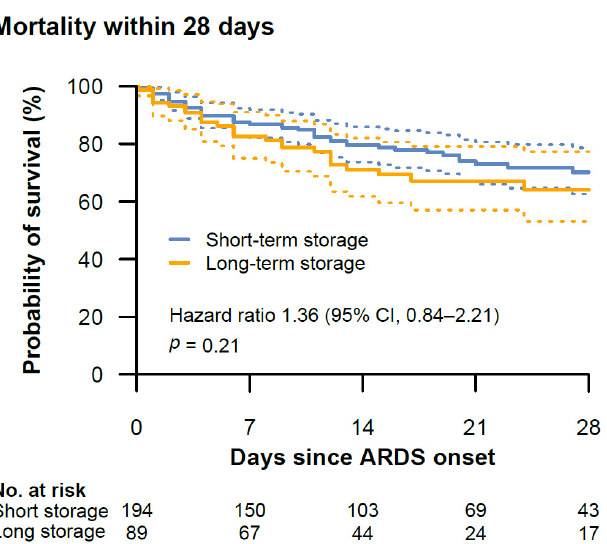
Figure 3. Kaplan–Meier survival curves with 95% confidence intervals (dotted lines) of the mortality within 28 days after onset of ARDS between the short-term and long-term storage group. The hazard ratio is provided with 95% confidence intervals. The median observation time was 20 days (IQR, 17–24) in the short-term storage group and 17 days (15–24) in the long-term storage group. The distribution of censoring was similar between the two groups ( p = 0.79).